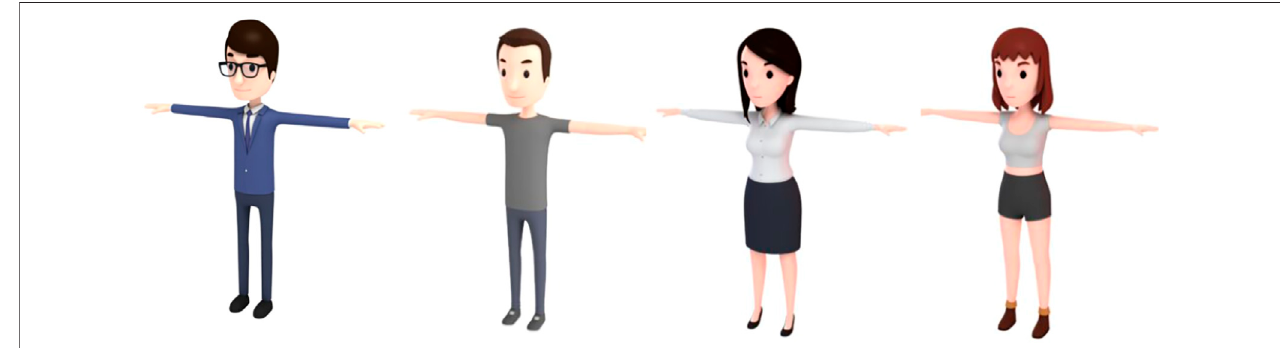
FIGURE 6 | Comparison of the used avatars. The left avatar of each gender represents the high socio-economic appearance.